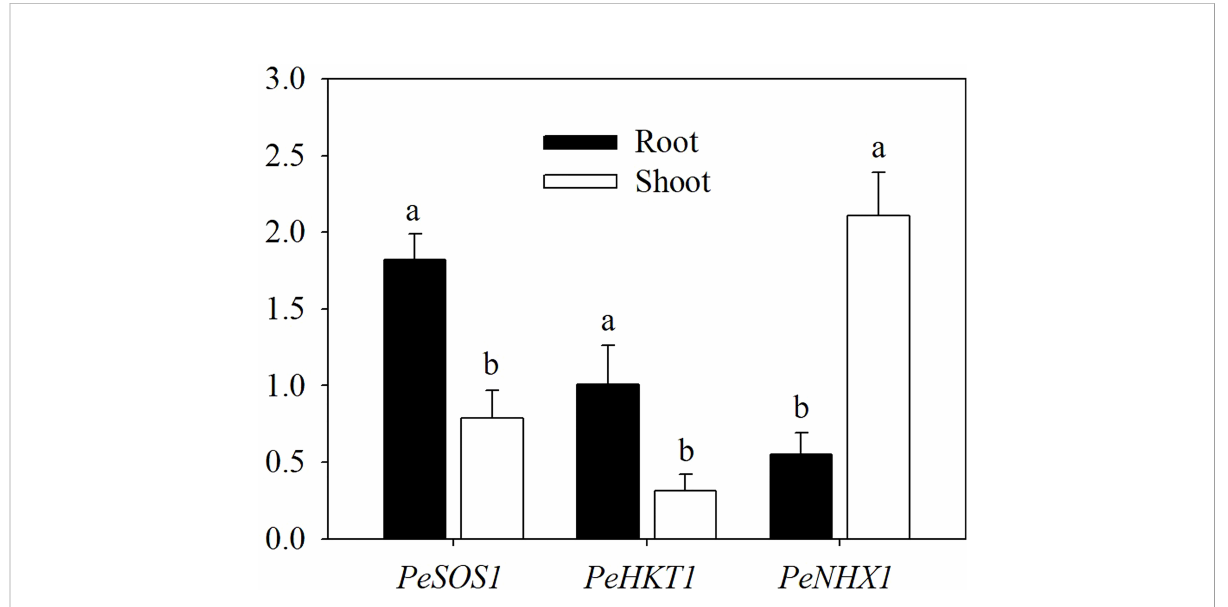
FIGURE 4 Tissue-speci fi c expression of PeSOS1 , PeHKT1 and PeNHX1 under salt stress. Different letters indicate signi fi cant difference at P ≤ 0.05, the data are means ± SD (n = 6).